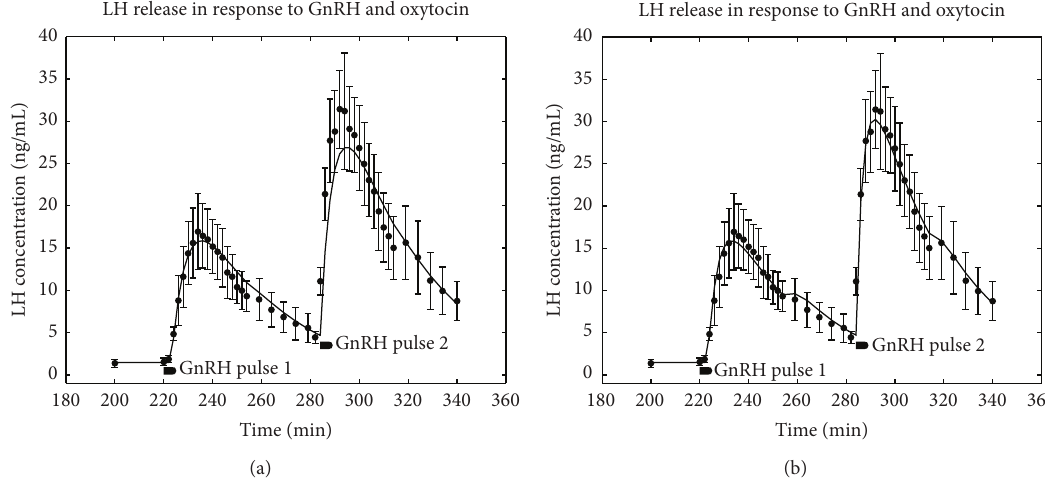
Figure 4: The optimal solution to the interaction model, (13), which results in an augmented response to the second stimulating pulse of GnRH. (a) The predicted result when the optimal solution for the OT parameter only was used. (b) In contrast showing what the model can achieve with an optimal solution for all